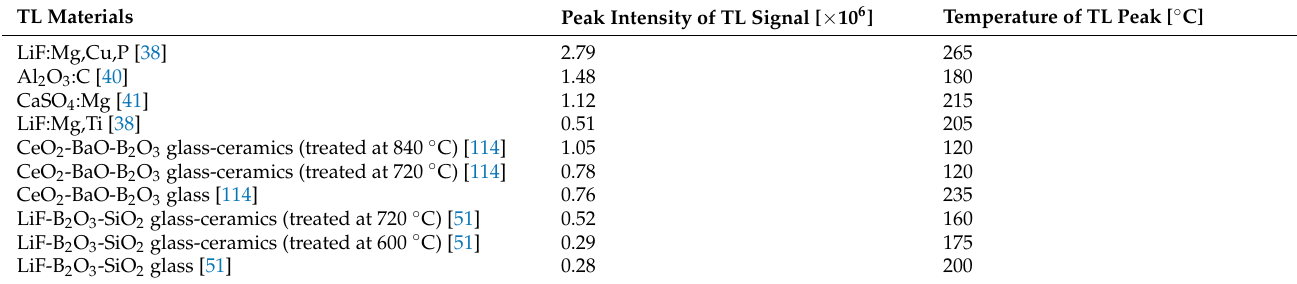
Figure 6. The comparison of the thermoluminescence glow curves for glassy and glass-ceramic material. ( a ) 5CeO 2 -20BaO- 75B 2 O 3 system [114], ( b ) 40LiF-30B 2 O 3 -30SiO 2 system [51]. Table 3. TL intensity at the peak and its temperature of various thermoluminescent materials for 10 Gy radiation dose measured with the 5 °C/min. heating rate.